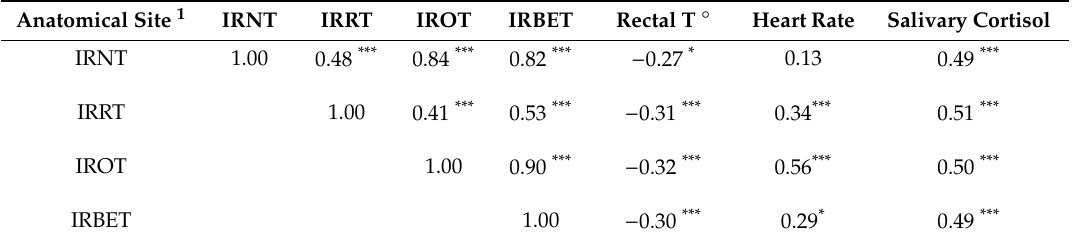
Table 9. Spearman correlations between infrared body surface temperatures assessed at four di ff erent anatomical sites and physiological